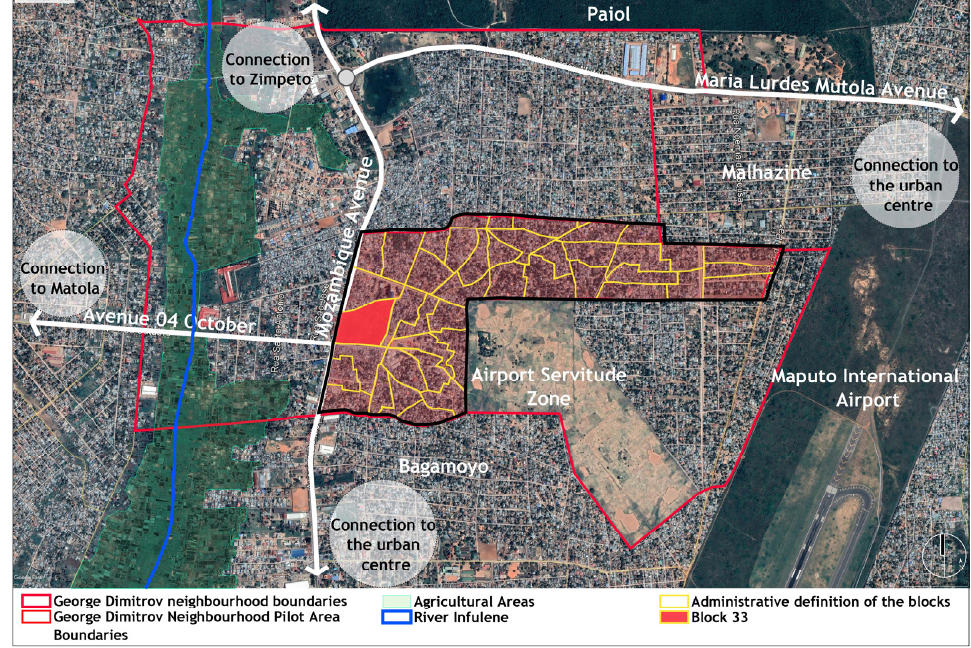
Figure 9. The context surrounding the George Dimitrov Neighbourhood (source: own authorship using Google Earth (2019) aerial photography).